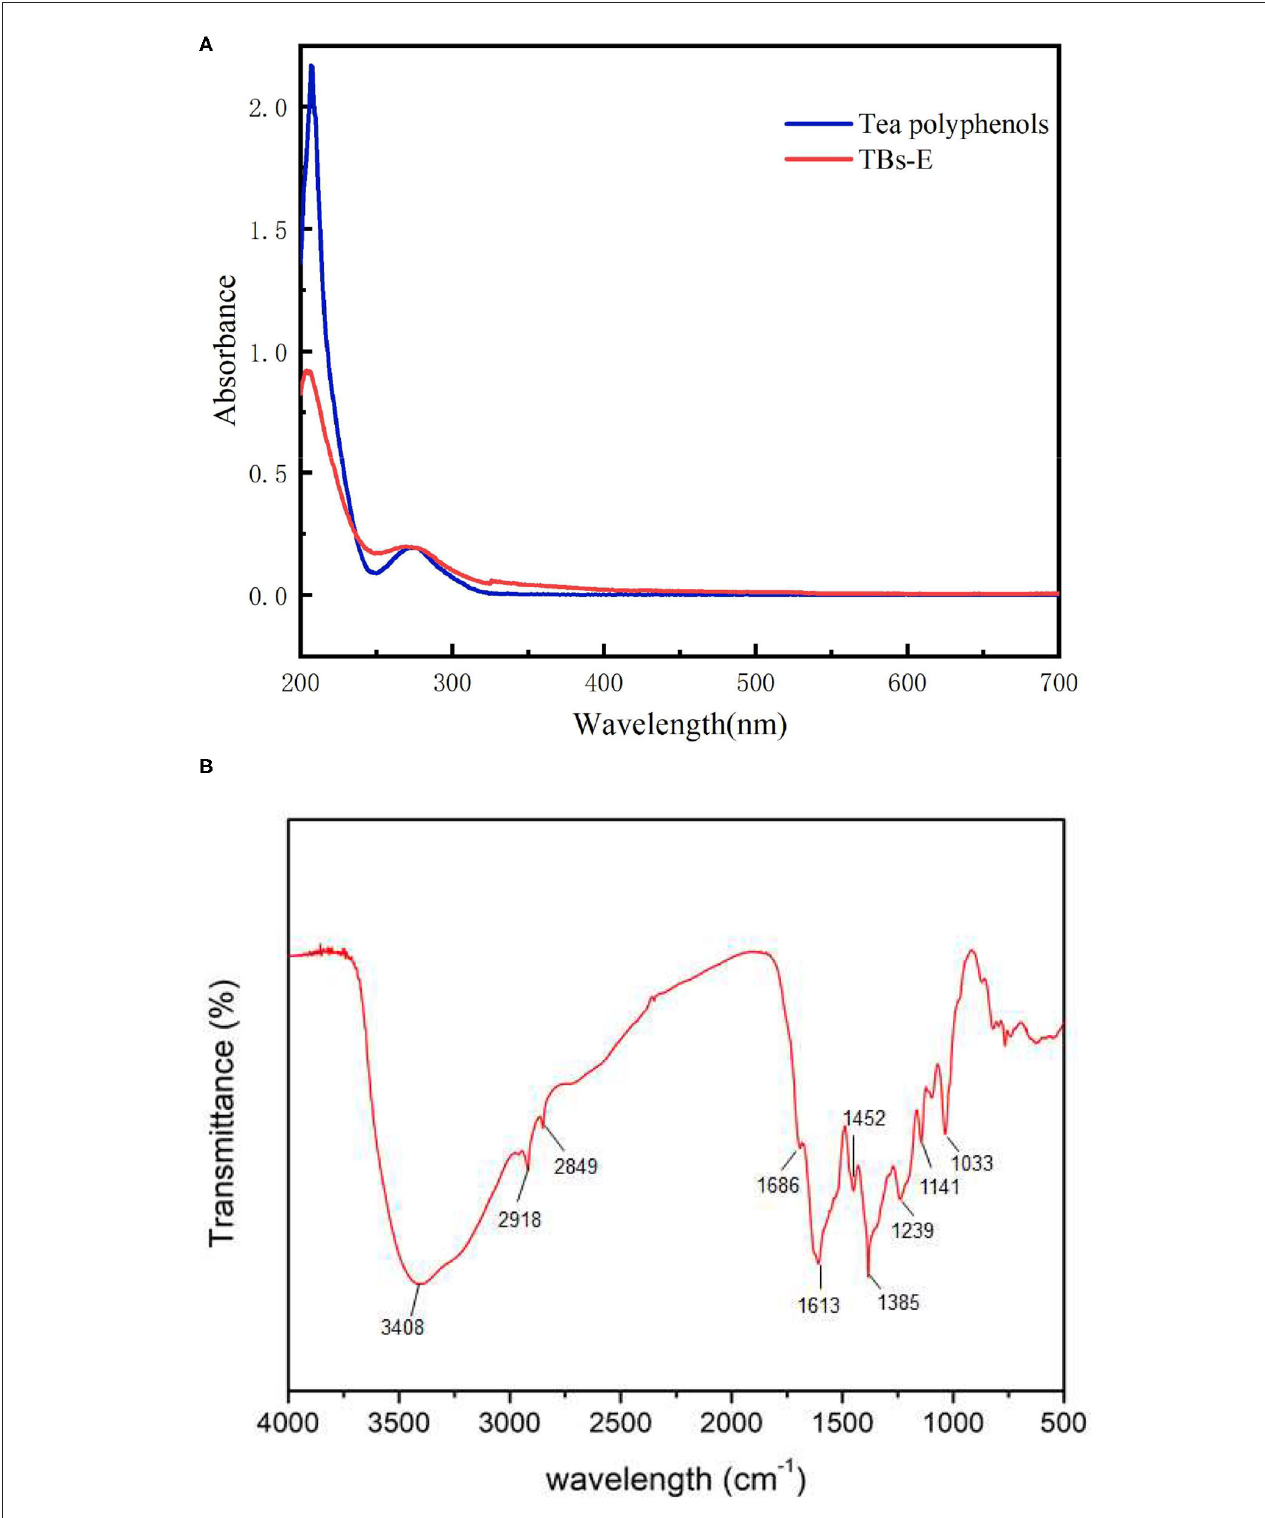
FIGURE 2 | UV-vis spectra of 10.00 µ g/ml TBS-E and 10.00 µ g/ml tea polyphenols in the 200–700nm scanning region (A) , and the Fourier-transform infrared spectrum of TBs-E in the 500–4,000 cm − 1 scanning region (B) .